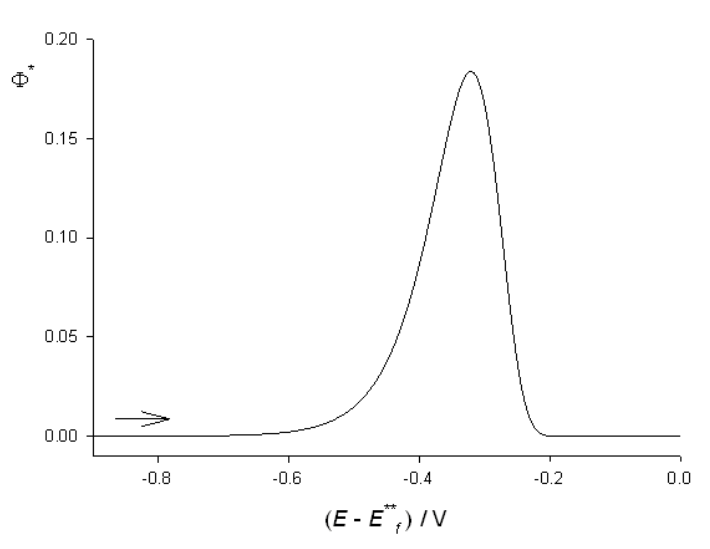
Fig. 6 Voltammetry of totally irreversible reaction (1); α = 0.5 (eq.